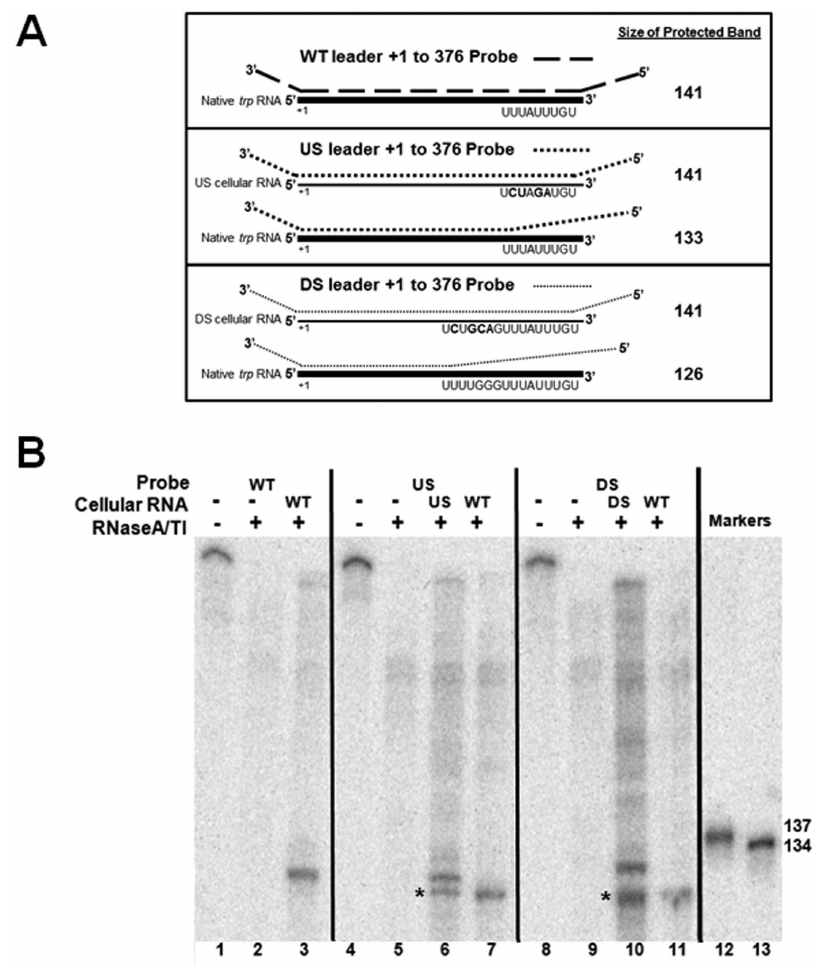
Figure 4. Mapping the site of TRAP-mediated transcription termination invivo . (A) Schematic diagram of RNase protection assays (RPA) using 32 P-labeled antisense probes and cellular RNA from B. subtilis . Antisense RNA probes are indicated as dotted lines and cellular RNA is displayed as solid lines (thick line for WT trp RNA and thin line for RNA from the mutant trpE 9 - 9 lacZ fusions). The WT antisense probe was hybridized to WT cellular RNA, and the mutant antisense probes, U-stretch (US) mutant or Disrupted stem (DS), were hybridized to RNA from B. subtilis containing mutant trpE 9 - 9 lacZ fusions, as well as to RNA from WT cells. The predicted lengths of the protected products are shown at the right side of the figure. (B) RNase protection assays to determine location of transcription termination in trp leader regions containing mutant attenuators. WT and mutant trp antisense RNA (Probes) were incubated with cellular RNA from WT B.subtilis or strains containing trpE 9 - 9 lacZ fusions with either the U-stretch (US) mutant or Disrupted stem (DS) mutant attenuator prior to digestion with RNaseT1/A. Black arrow represents the location of transcripts terminated at the WT attenuator; (*) indicates bands that are from probes designed to hybridize with transcripts terminated at mutant attenuator present in trpE 9 - 9 lacZ fusion when they pair with native WT trp leader transcripts terminated at the WT attenuator. Reactions were run on 8% denaturing polyacrylamide gels. Markers were generated by T7 RNAP run off transcription of templates that contain an XbaI site from + 133–138, or a PstI site from + 134–139 relative to the start of transcription respectively. In each case a T7 promoter was placed upstream of the template so that transcription initiation occurs at + 1. The 137 nt RNA marker was generated by transcription of the XbaI cleaved template, and the 134 nt RNA marker was from template cut with